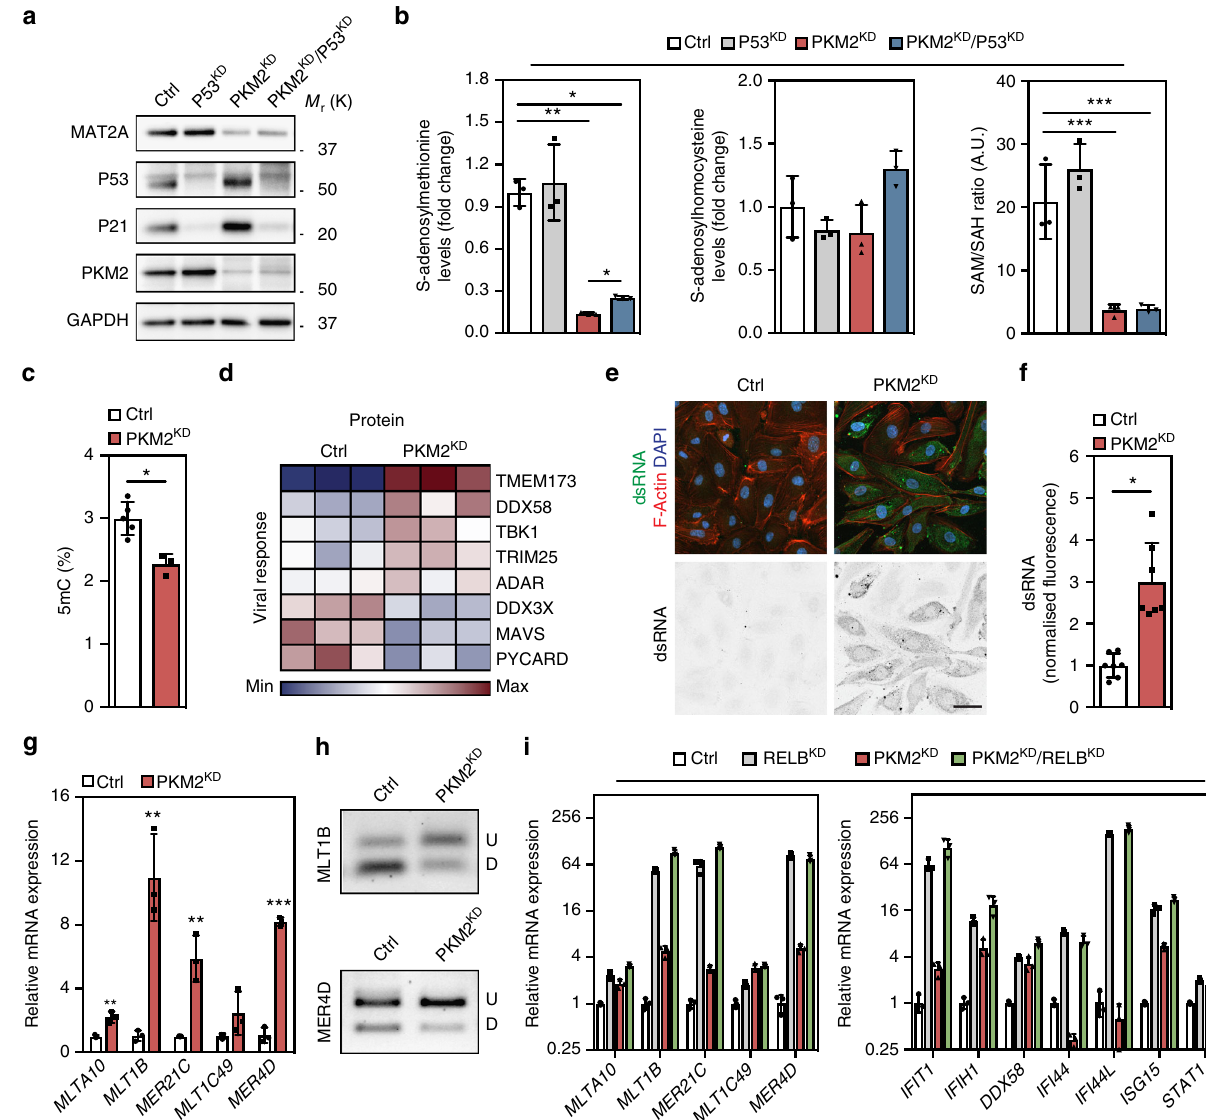
Fig. 6 Loss of PKM2 impairs methylation capacity, reduces DNA methylation and leads to the expression of endogenous retroviral elements. a Western blot analysis of MAT2A, P53, P21 and PKM2 in control, P53 KD , PKM2 KD and PKM2 KD /P53 KD ECs. b Relative levels of S-adenosylmethionine and S- adenosylhomocysteine and SAM/SAH ratio in control, P53 KD , PKM2 KD and PKM2 KD /P53 KD ECs ( n = 3). c Percentage 5-methylcytosine (5mC) levels in control and PKM2 KD ECs ( n = 4). d Heat map of protein expression for components of the cellular response to viral infection in control and PKM2 KD ECs. e Representative confocal projections of total double-stranded RNA (dsRNA) staining in control and PKM2 KD ECs (scale bar = 20 μ m). f Normalized fl uorescence intensity for dsRNA staining in control and PKM2 KD ECs ( n = 7). g Relative mRNA expression of the indicated endogenous retroviruses in control and PKM2 KD ECs ( n = 3). h Restriction digestion of bisul fi te-treated DNA ampli fi ed from the MLT1B and MER4D genomic loci from control and PKM2 KD ECs (U, undigested/unmethylated DNA; D, digested/methylated DNA). i Relative mRNA expression of the indicated endogenous retroviruses and interferon-stimulated genes in control, RELB KD , PKM2 KD and PKM2 KD /RELB KD ECs. b , c , f , g , i Data represent means ± s.d. (*** P < 0.001, ** P < 0.01, * P < 0.05 by one-way analysis of variance (ANOVA) followed by Tukey ’ s HSD